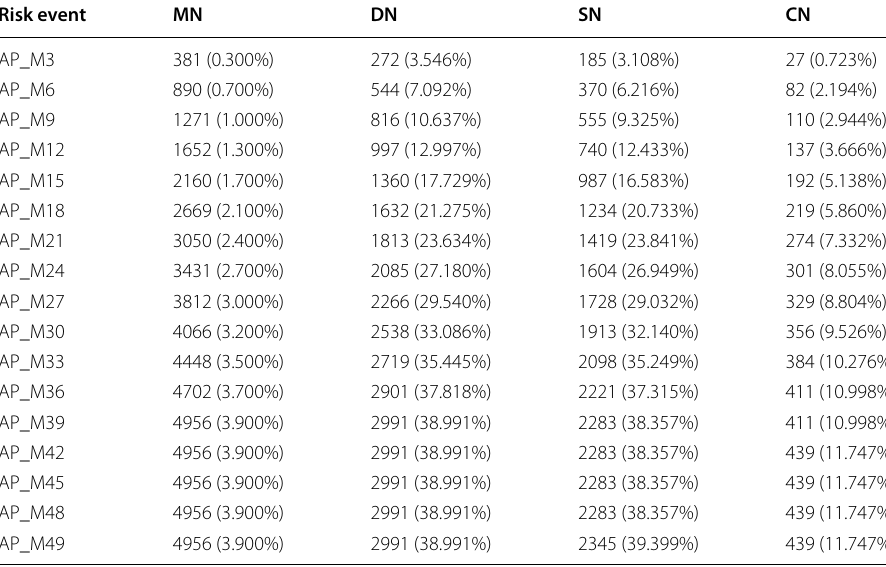
Table 16 Summary statistics of AP in different networks on NEEQ SMEs dataset Risk